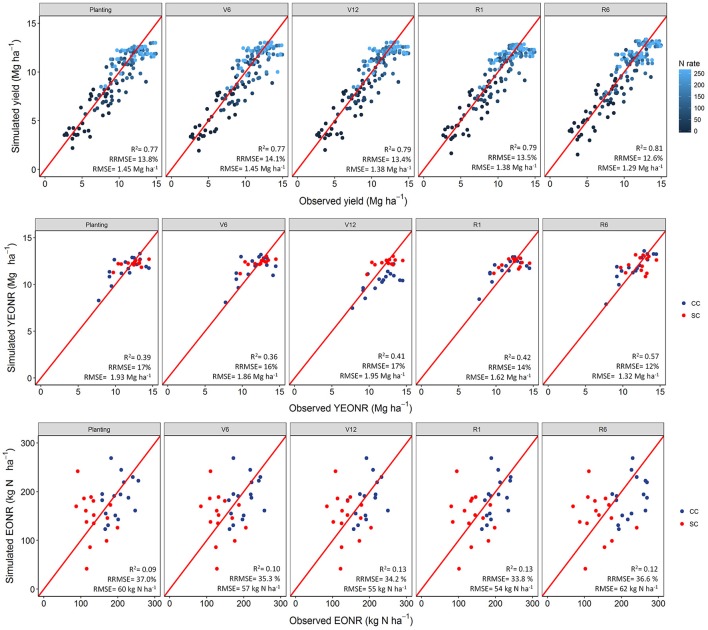
Simulated vs. observed corn yield (Top panel), economic optimum N rate (Bottom panel, EONR), and yield at EONR (Central panel, YEONR) at different corn stages using 35-yr weather data. In the top panels data presented by N-rate while in the bottom panels data presented by cropping system: CC, continuous corn and CS, soybean-corn. The V6 and V12 are the 6th and 12th leaf stage, respectively; R1 and R6 are silking and physiological maturity stages, respectively (Abendroth et al., 2011).